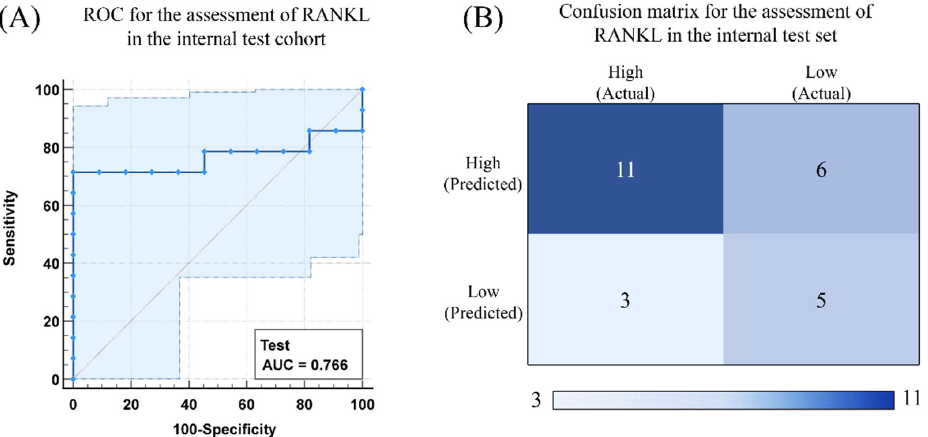
Figure 8. ( A ) ROC curves for prediction of RANKL status in the testing cohorts. ( B ) Confusion matrix for predicted outcomes of RANKL expression levels in the test cohort.